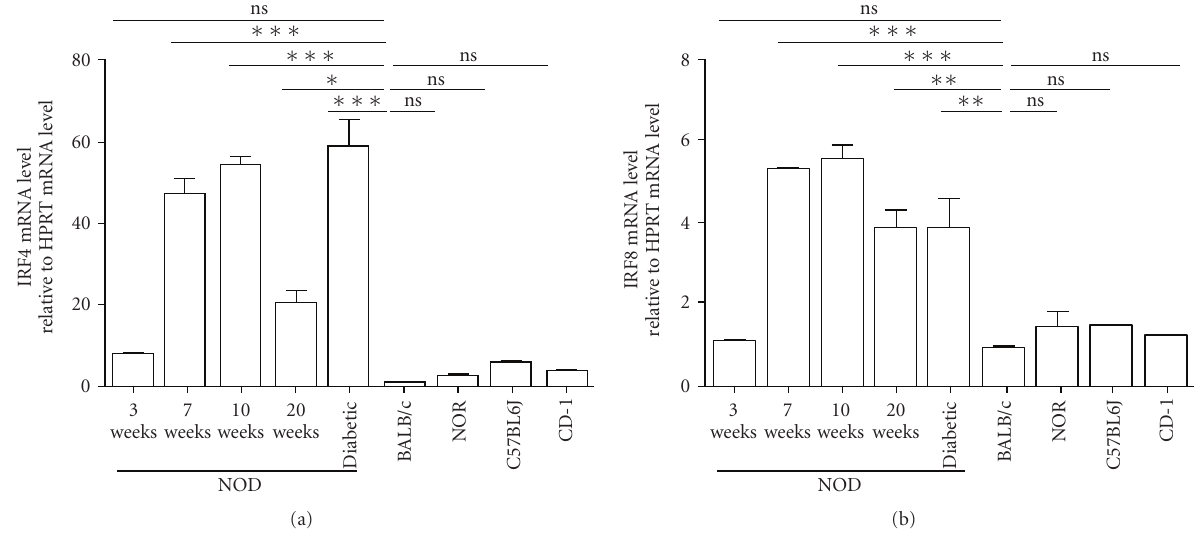
Figure 1: Age-related IRF4 and IRF8 mRNA expression levels in splenocytes of diabetes-prone and diabetes-resistant mice. Total splenic RNA was obtained from NOD, NOR, C57BL/6J, CD-1, and BALB/c mice, purified and gene expression profile of IRF4 (a) and IRF8 (b) were analyzed by real time RT-PCR. Each RNA sample was analyzed in triplicates and normalized to HPRT expression ( Δ Ct). Each NOD sample was normalized to a BALB/c sample ( ΔΔ Ct = Δ Ct sample − Δ Ct BALB/c) and, the expression level was calculated as follows: 2 − ΔΔ Ct . Data are shown as the average ± SD of 4 independent experiments ( ∗ P < . 05, ∗∗ P < . 01 and ∗∗∗ P < .